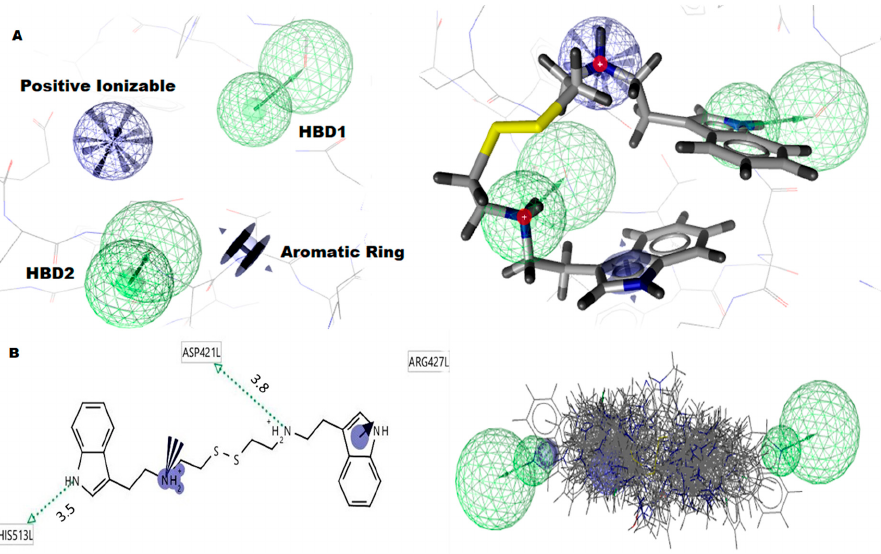
Figure 2. Pharmacophore model of G6PD-AG1-complex. ( A ) The pharmacophore model contains four pharmacophore features, such as two hydrogen donors (green color), one positive ionizable, and one aromatic ring ( B ). The G6PD-AG1 compound interacts with His513, ASP421, and ARG427 functional residues. The 53 hit molecules are fitted into pharmacophore features which are applied to the PubChem database.